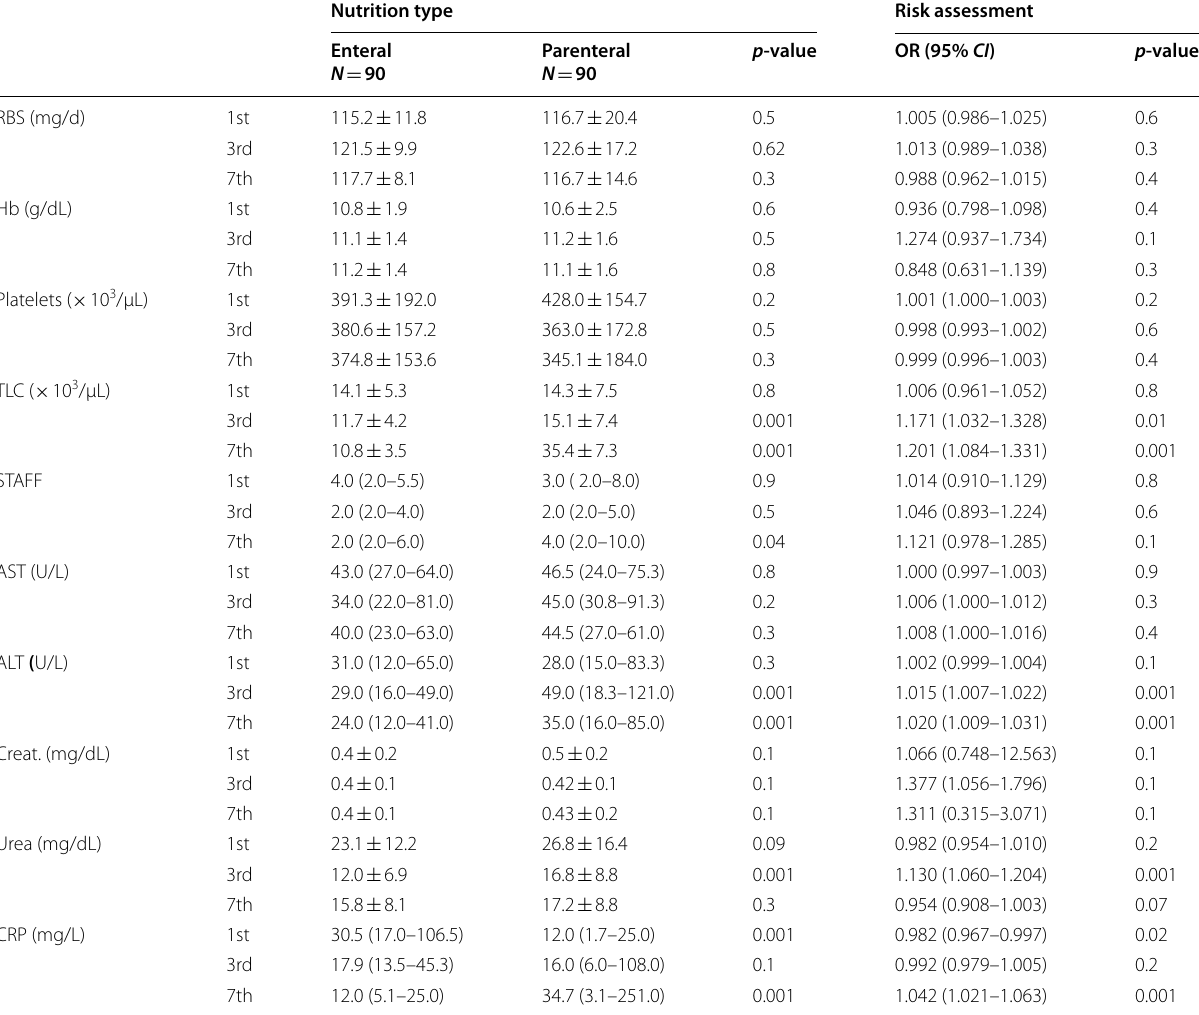
Table 3 Comparison between both groups as regards laboratory investigations